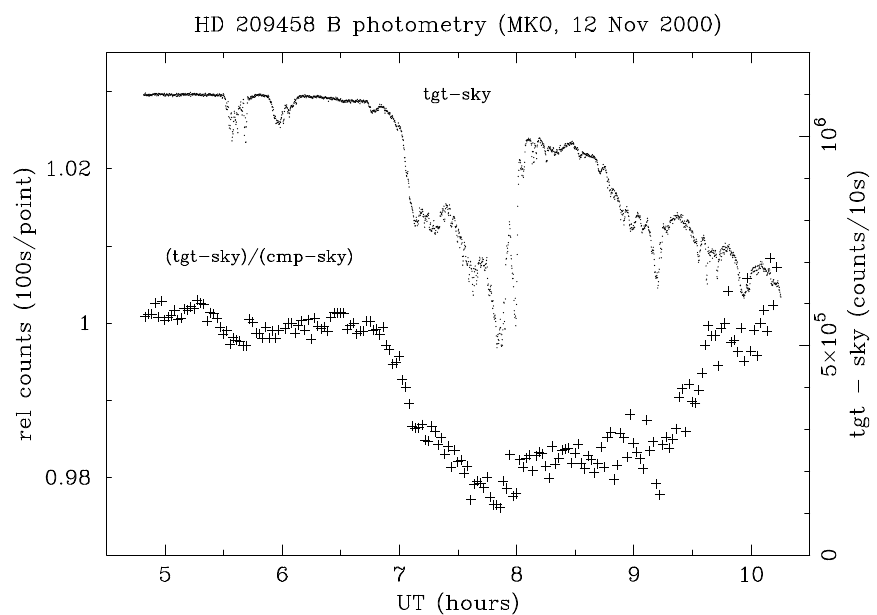
Fig. 7. Sky-corrected target/comparion ratios (vertical scale on the left) for 100 s effective integration